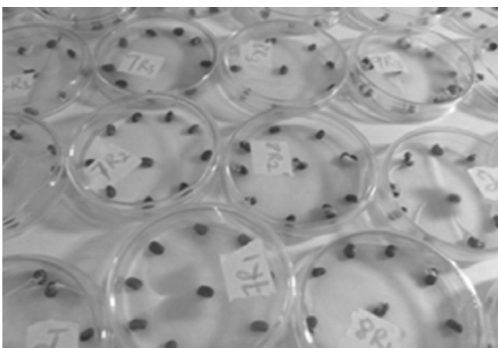
Figure 1: Cowpea seeds plated on moistened filter papers in Petri